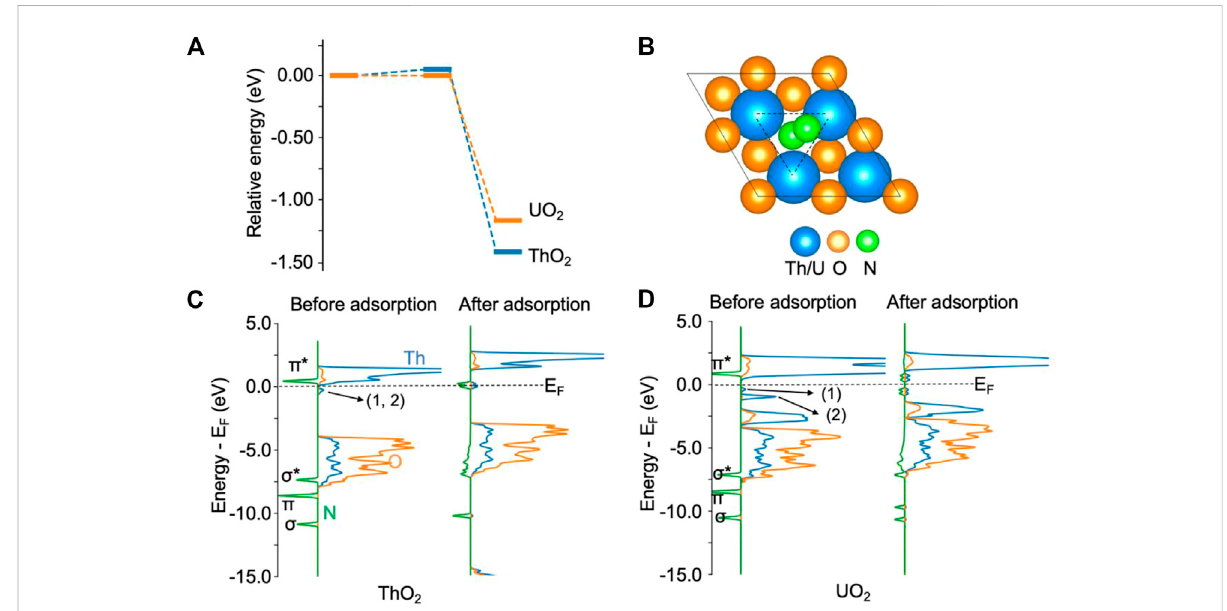
FIGURE 1 N 2 adsorption on ThO 2 and UO 2 (111) surfaces containing oxygen vacancies. (A) Adsorption energy diagram. The total energy of the initial state is set to zero. (B) Illustration of structures after N 2 adsorption. The oxygen vacancy site is highlighted by the triangle. (C) Density of states before and after N 2 adsorption on the ThO 2 surface. (D) Density of states before and after N 2 adsorption on the UO 2 surface. The two excess electrons on the